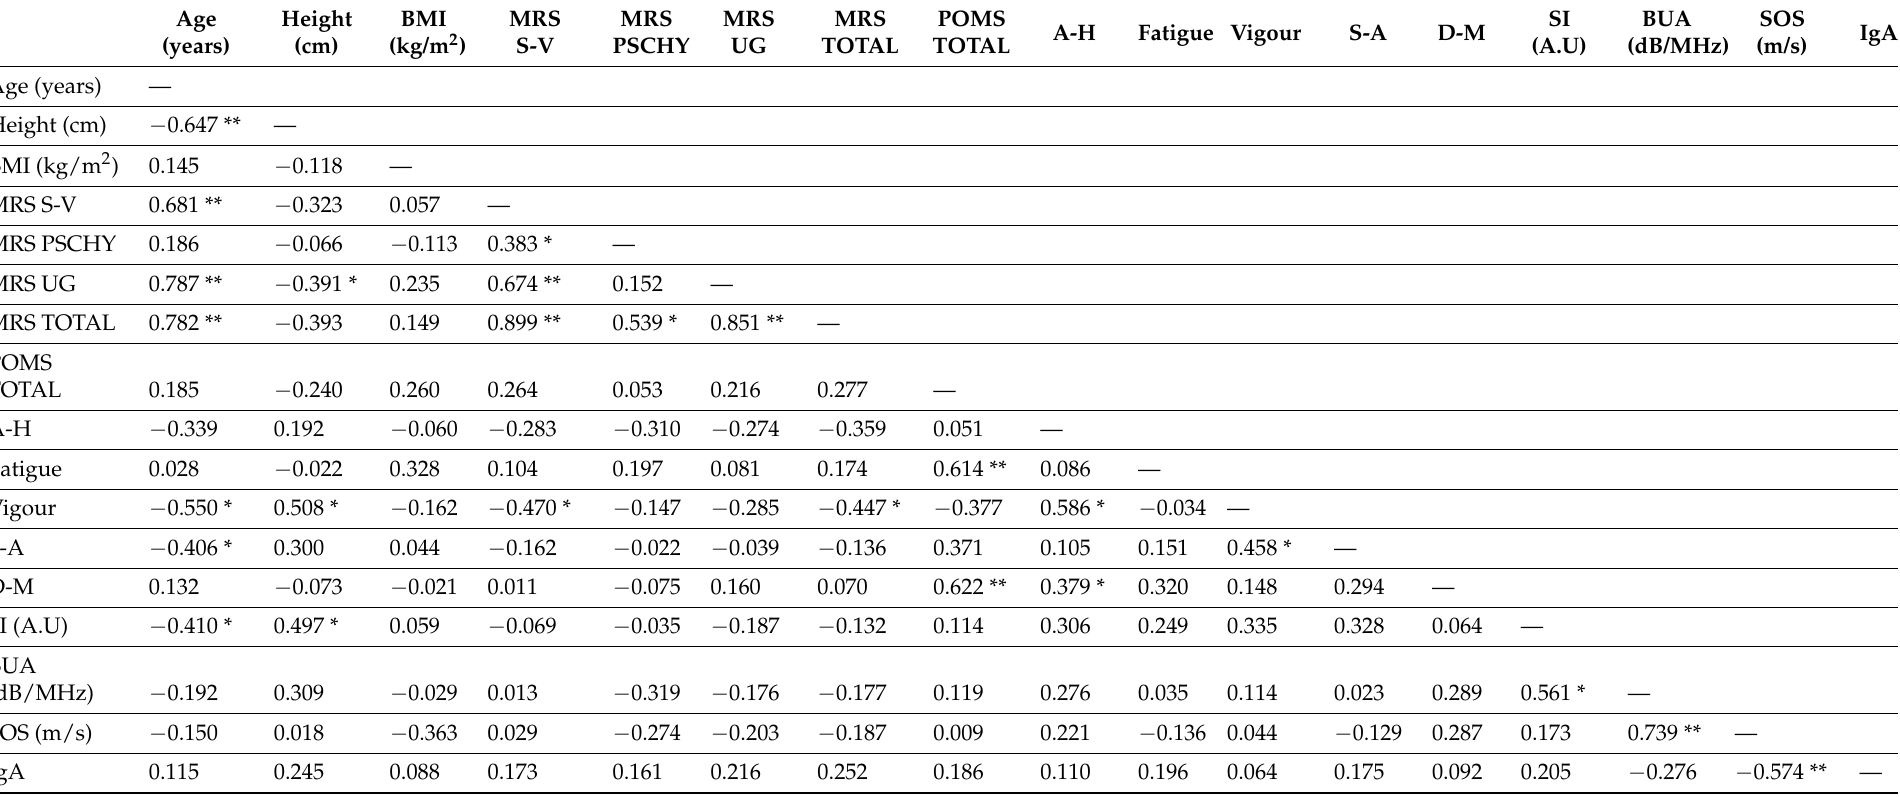
Table 2. Correlations between the different variables analysed in the